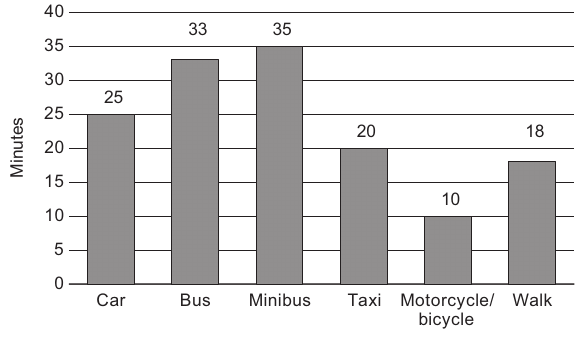
Fig. 8. Average travel time based on the type of transportation in the city of Pristina.